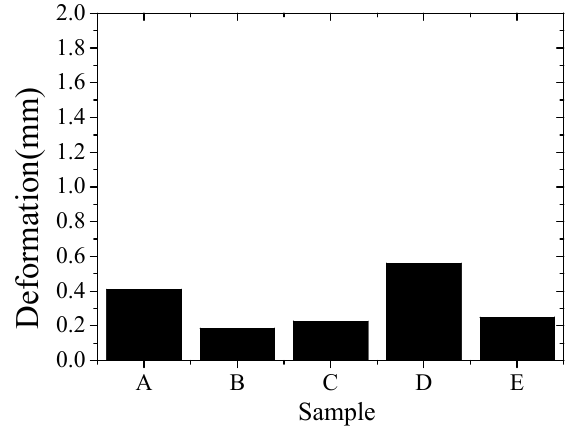
Figure 8. Deformation after quenching.